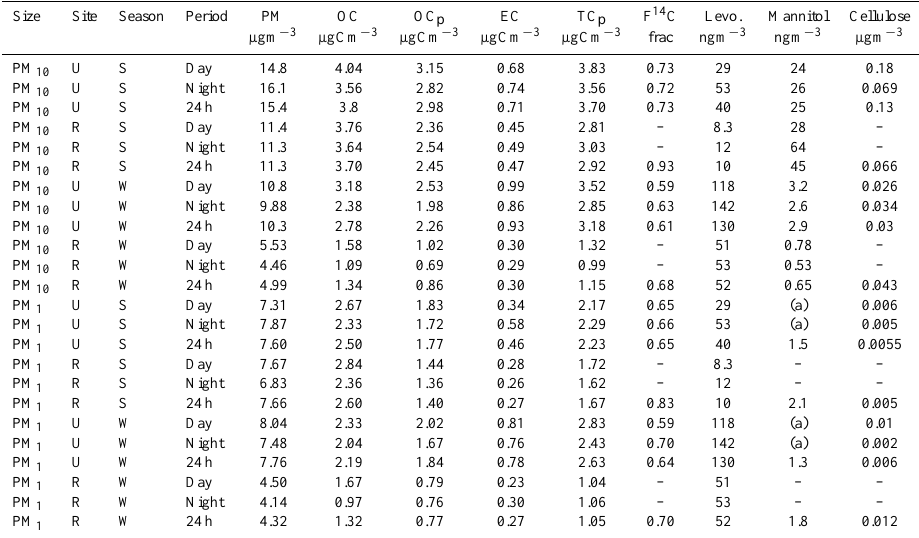
Table 4. Measured concentrations of aerosol components. Size